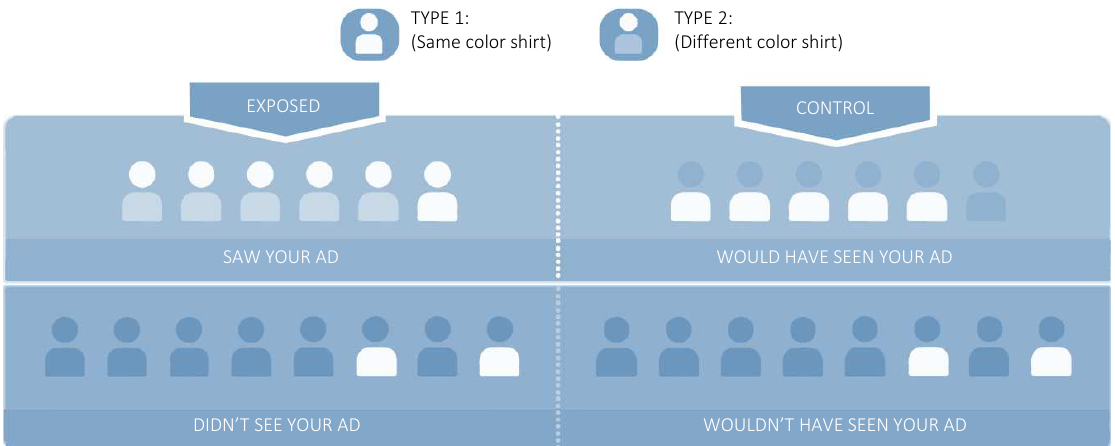
THE USERS shirt)TYPE 1: (Same color